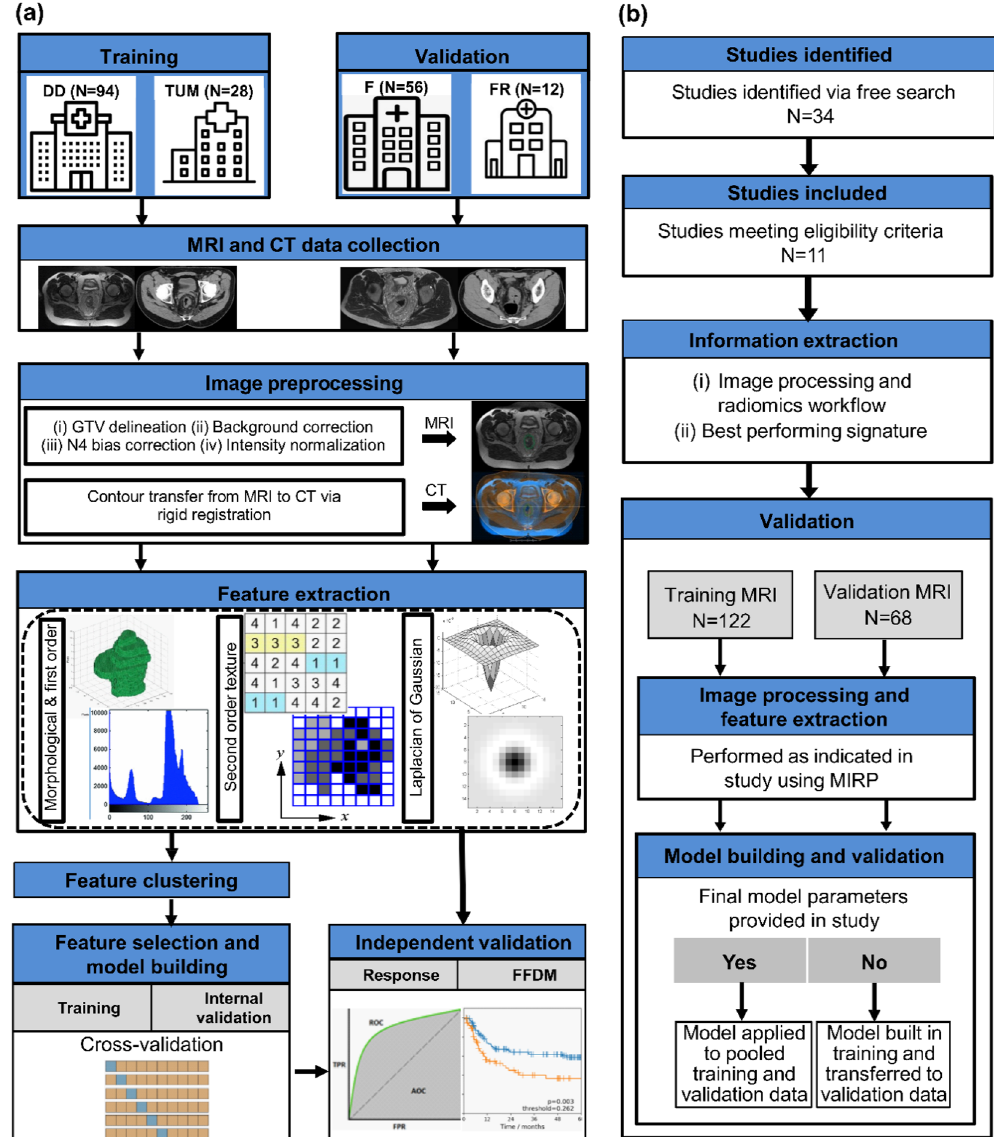
Figure 1. ( a ) Design of the modelling study. Treatment plan computed tomography (CT) and pre-treatment T2w magnetic resonance imaging (MRI) data were collected from 4 centres and divided into training and validation data. MRI data was preprocessed and gross tumour volume (GTV) was delineated, which was then transferred to CT images after rigid registration. Different feature classes were extracted from both modalities and signatures were developed on training data for tumour response prediction to neoadjuvant chemoradiotherapy (nCRT) and freedom from distant metastases (FFDM) in a cross-validation setting. These signatures were validated independently for both endpoints. ( b ) Design of the external validation study. Studies were identified via free search using Google scholar and PubMed and excluded if the inclusion criteria were not fulfilled. Information regarding image processing, radiomics workflow, and the best performing radiomics signature was extracted as reported. Image processing and feature extraction was reproduced using MIRP 34 . Finally, validation was performed either on the pooled training and validation data if model parameters were reported in the study or the model was re-trained on the training data and validated on the validation